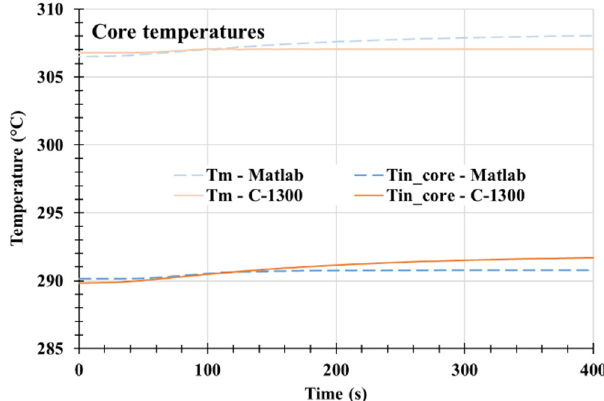
Fig. 10. Comparison of core temperatures for the grid-following validation case.